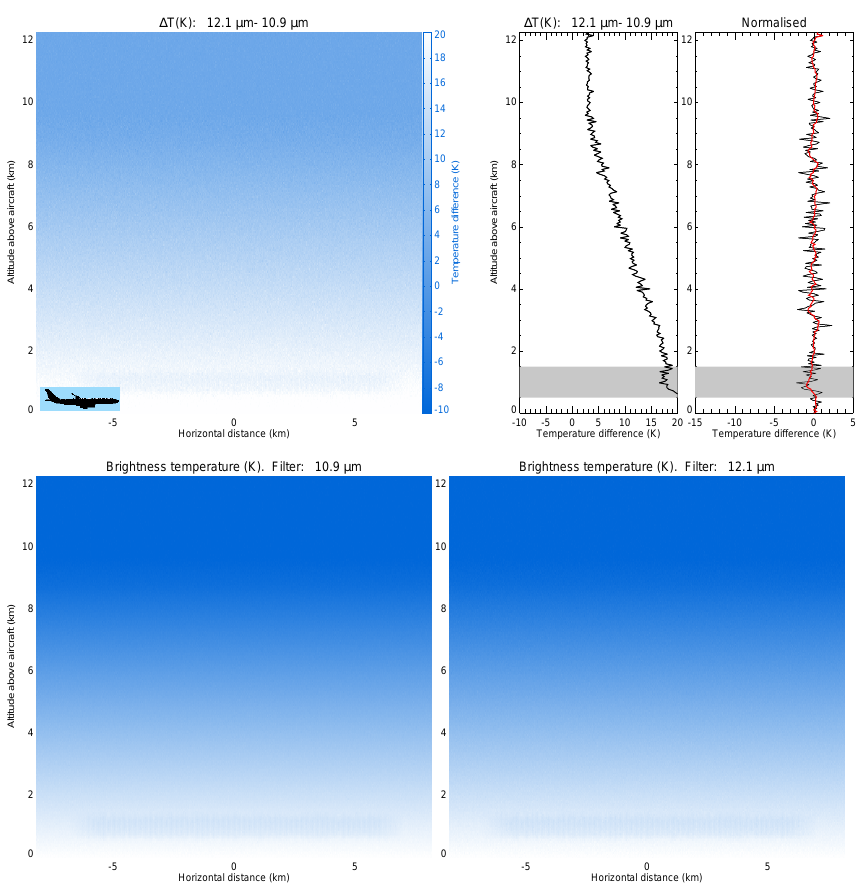
29,500 ft) Figure 9. Ash Radiative Transfer (ART) model simulation for an aircraft cruising at 9 km ( 29,500 ft) and viewing an ash cloud slightly Figure 9. ART model simulation for an aircraft cruising at 9 km ( ∼ ∼ above. Top-left: Temperature difference image (12.1-10.9 µ m). Top-right: Vertical profiles of the temperature and viewing an ash cloud slightly above. Top-left: Temperature difference image (12.1–10.9 µ m). difference – the right-hand panel shows a normalised temperature difference. Bottom panels: Individual Top-right: Vertical profiles of the temperature difference—the right-hand panel shows a normalised temperature images. The mean effective particle radius is 3 µ m typical of dispersing ash clouds in the temperature difference. Bottom panels: Individual temperature images. The mean effective particle atmosphere and a mass loading of 0.2 g m − 2 is assumed. The mean anomaly is –0.40 K; the minimum anomaly is –2.23 K and the maximum anomaly is 1.07 K. The aircraft altitude is 9 km (29527 ft). radius is 3 µ m typical of dispersing ash clouds in the atmosphere and a mass loading of 0.2 g m − 2 is assumed. The mean anomaly is 0.40 K; the minimum anomaly is 2.23 K and the maximum anomaly − − is 1.07 K. The aircraft altitude is 9 km (29,527